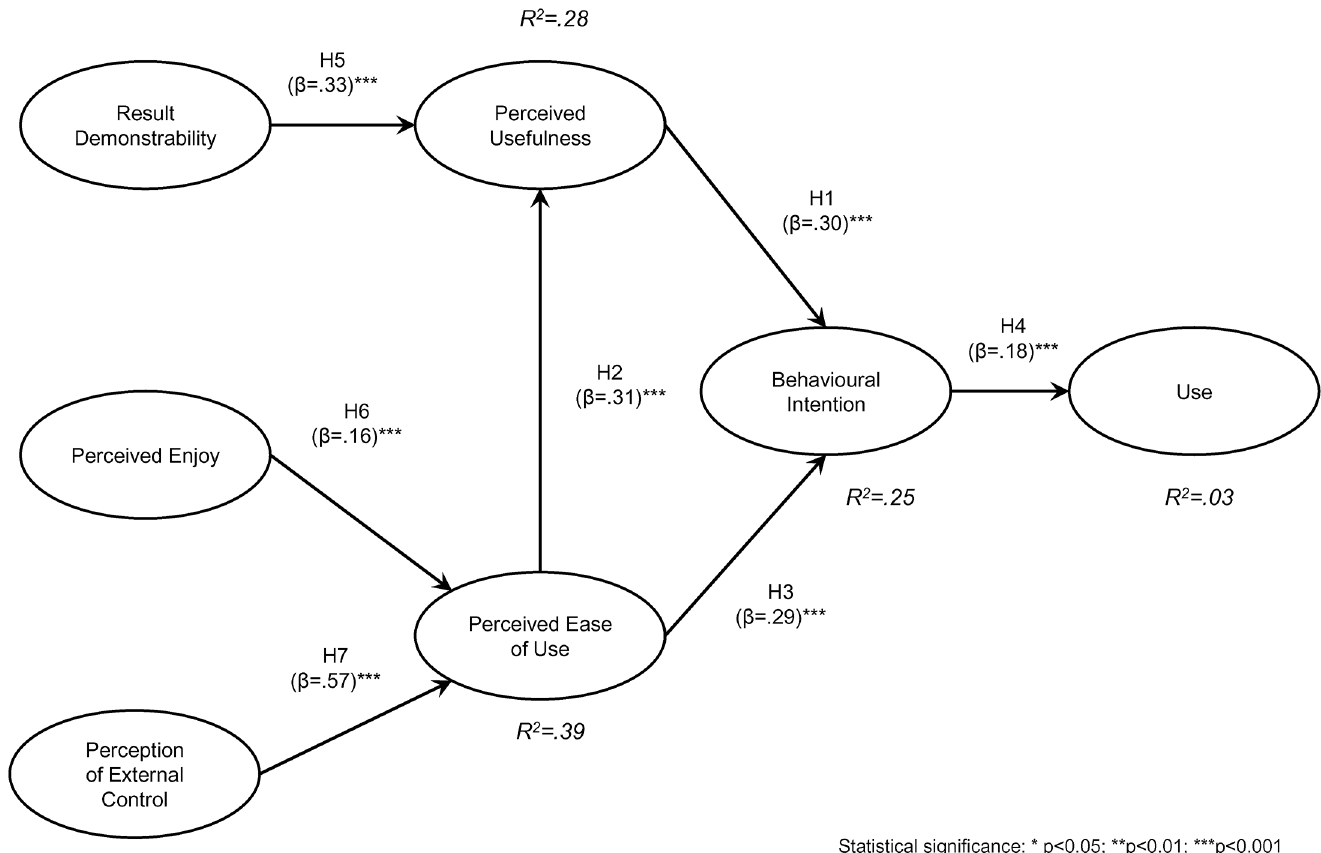
Fig 2. Partial Least Squares results for the whole